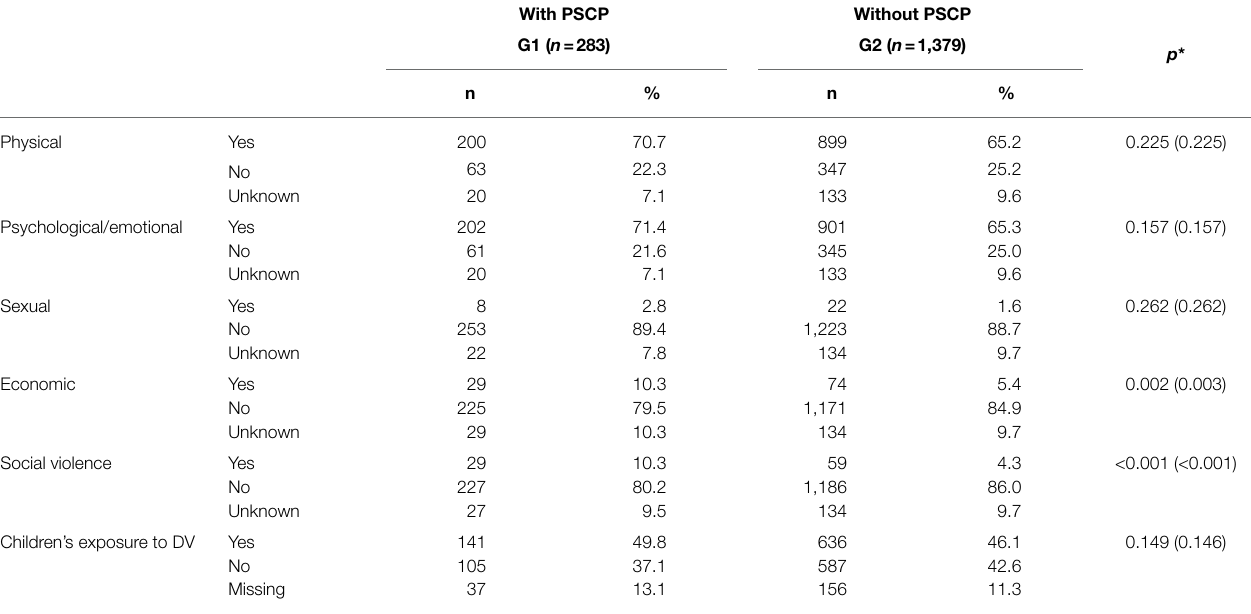
TABLE 3 | Types of violence registered and children’s exposure to